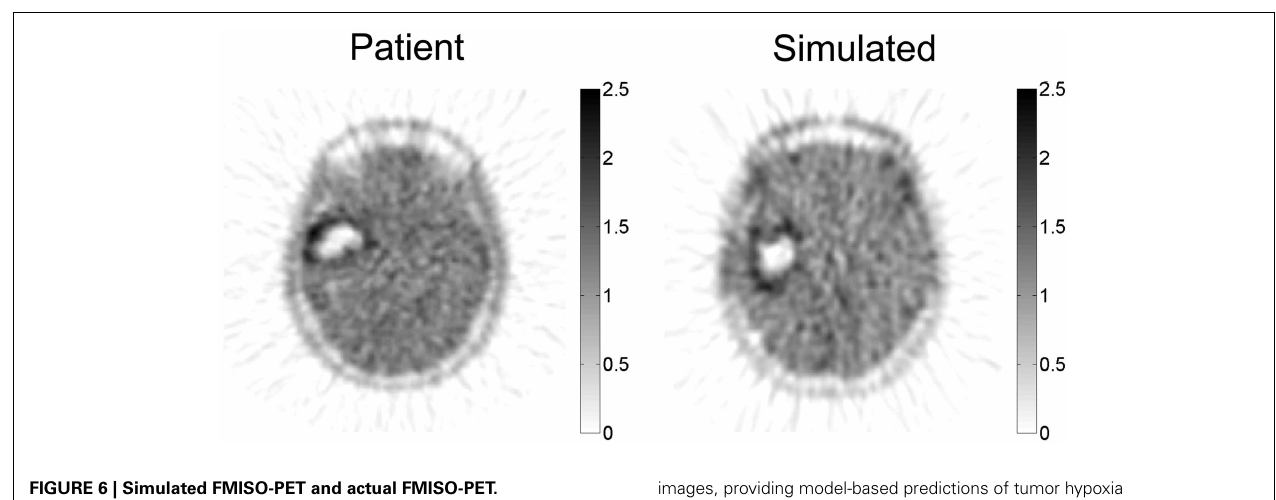
FIGURE 6 | Simulated FMISO-PET and actual FMISO-PET. Hypoxia is predicted by the PIHNA model and an imaging reconstruction algorithm produces the simulated FMISO-PET. Pixel intensity distribution is not statistically different between the two